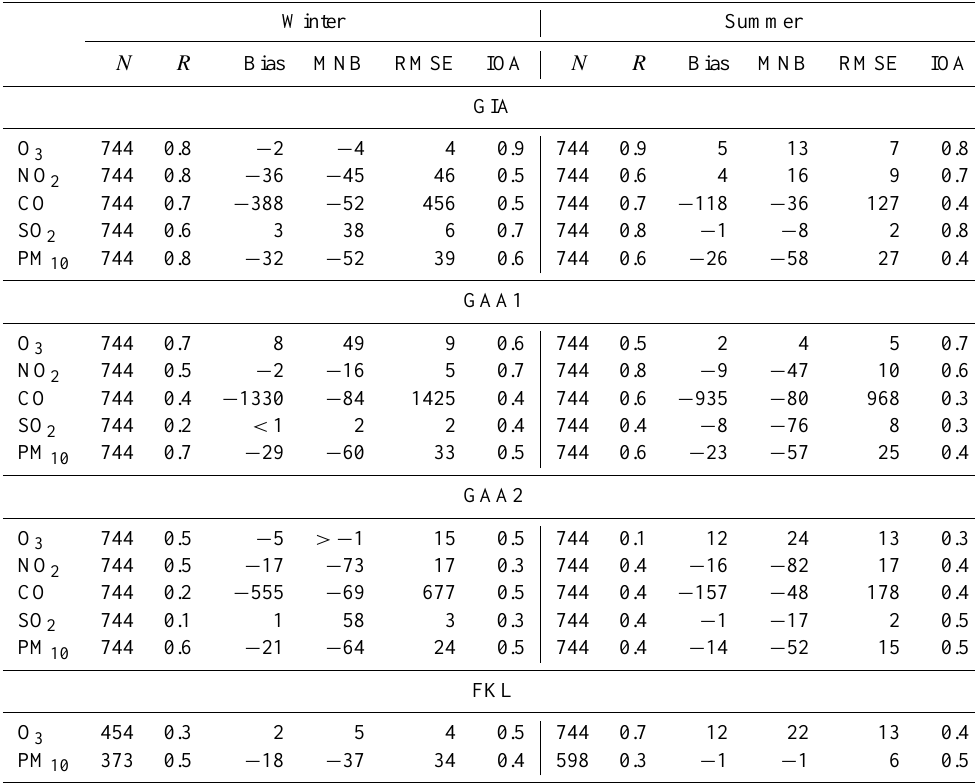
Table 2. Simulated vs. observed surface concentrations of O 3 , NO 2 , CO, SO 2 and PM 10 over GIA, GAA and FKL in winter (December) and summer (July) 2008. Bias and RMSE are in ppbv for O 3 , NO 2 , CO and SO 2 and in µg . m − 3 for PM 10 . MNB is in percent. R and IOA have no units. N denotes the number of points used in the comparisons. The equations used to calculate these statistics are provided in the